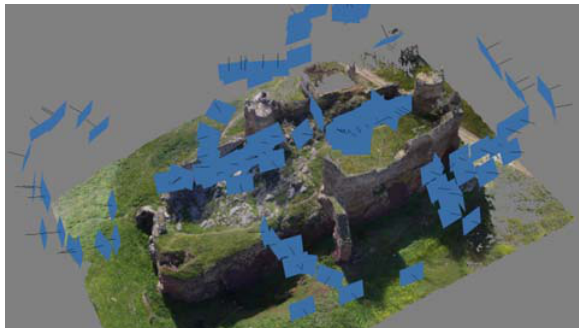
Figure 19. Manual image acquisition mode in the Berrueco Castle with Phantom DJ 3 Advanced.